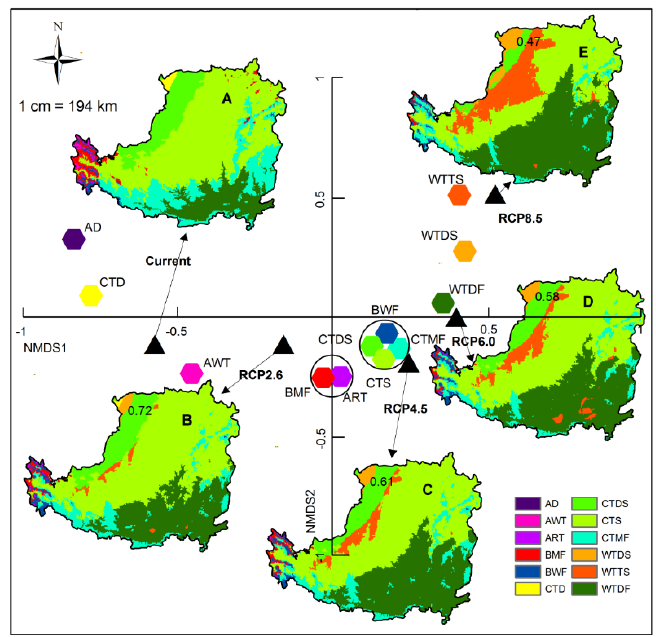
Figure 3. Twelve vegetation zones (life zones) under both current climate conditions and future climate change scenarios on Loess Plateau in the Holdridge Life Zone model system. Except for warm temperate desert scrub and warm temperate thorn steppe zones, all other zones occurred under the current climate situation. The alvar desert zone will disappear under future climate scenarios.